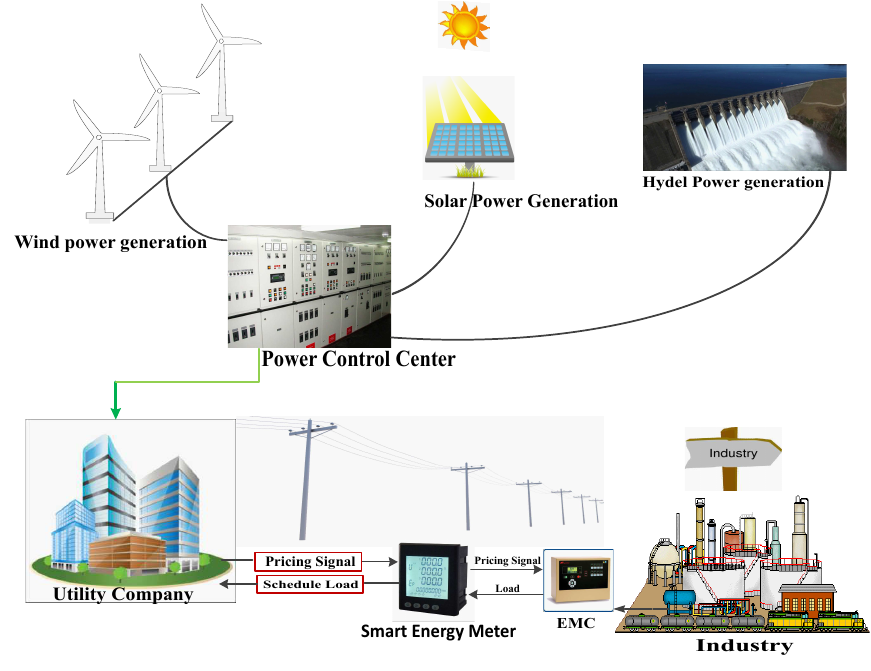
Figure 1. System Model Architecture.